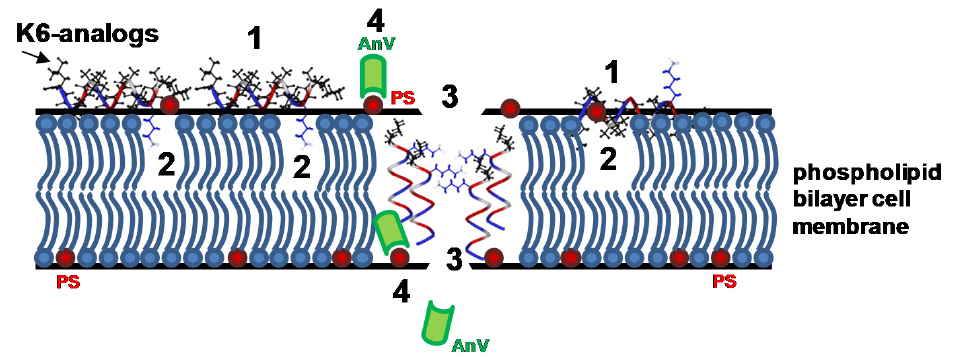
Figure 8. Proposed mechanism of peptide–membrane interaction of K6-analogs. ( 1 ) The Lys residue at position 6 of K6-analogs (in black) could interact with the hydrophilic heads of phospholipid membranes ( 2 ) promoting helix insertion ( 3 ), leading to cell membrane permeabilization by pore formation and ( 4 ) Annexin-V staining. Phosphatidylserine (PS) (in red) could translocate and appear in the external membrane and bind to Annexin-V (AnV) (in green), or Annexin-V could diffuse and then bind PS on the inner leaflet.